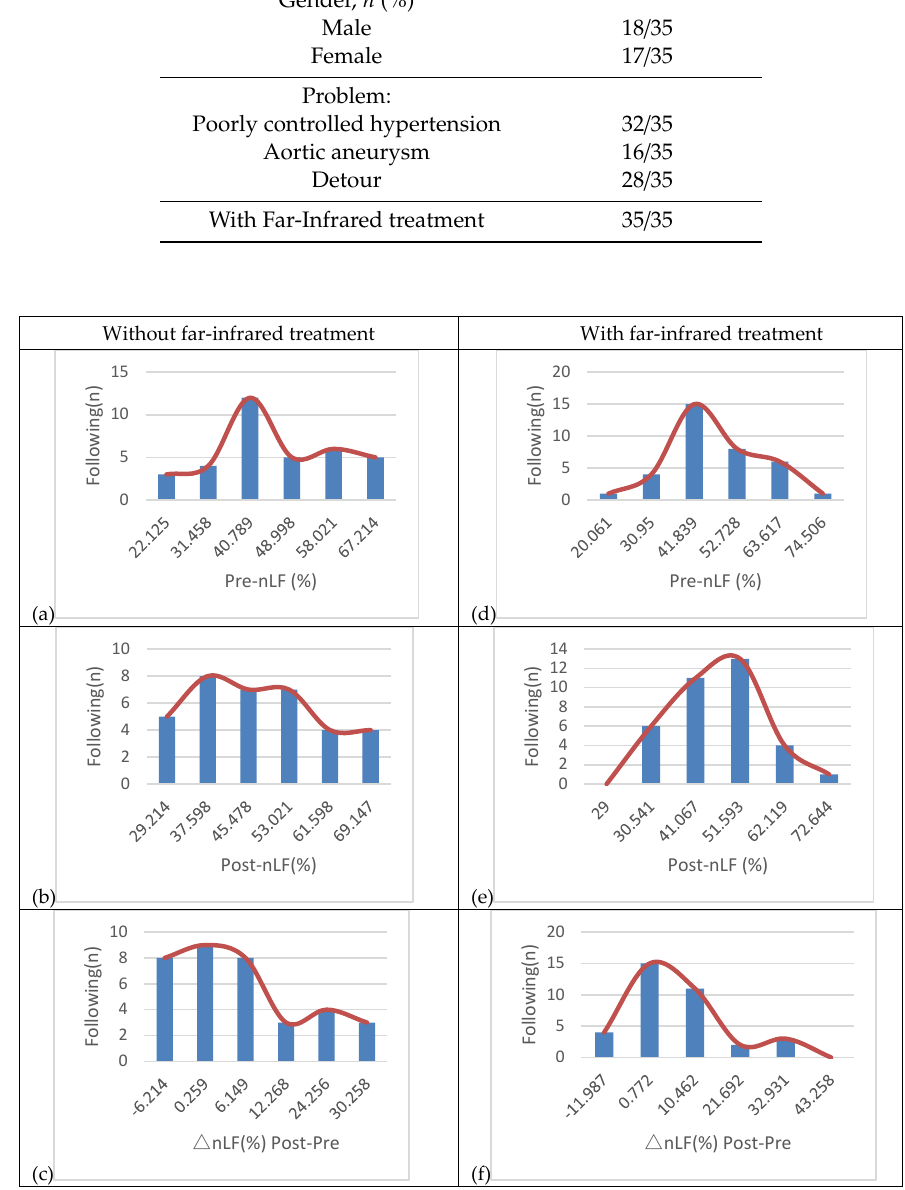
Figure 12. Without far-infrared treatment: ( a ) LF/HF before-HD, ( b ) LF/HF after-HD, ( c ) autonomic nerve activation observed; with far-infrared treatment ( d ) LF/HF before-HD, ( e ) LF/HF after-HD, and ( f ) autonomic nerve activation observed. Note: hemodialysis (HD)